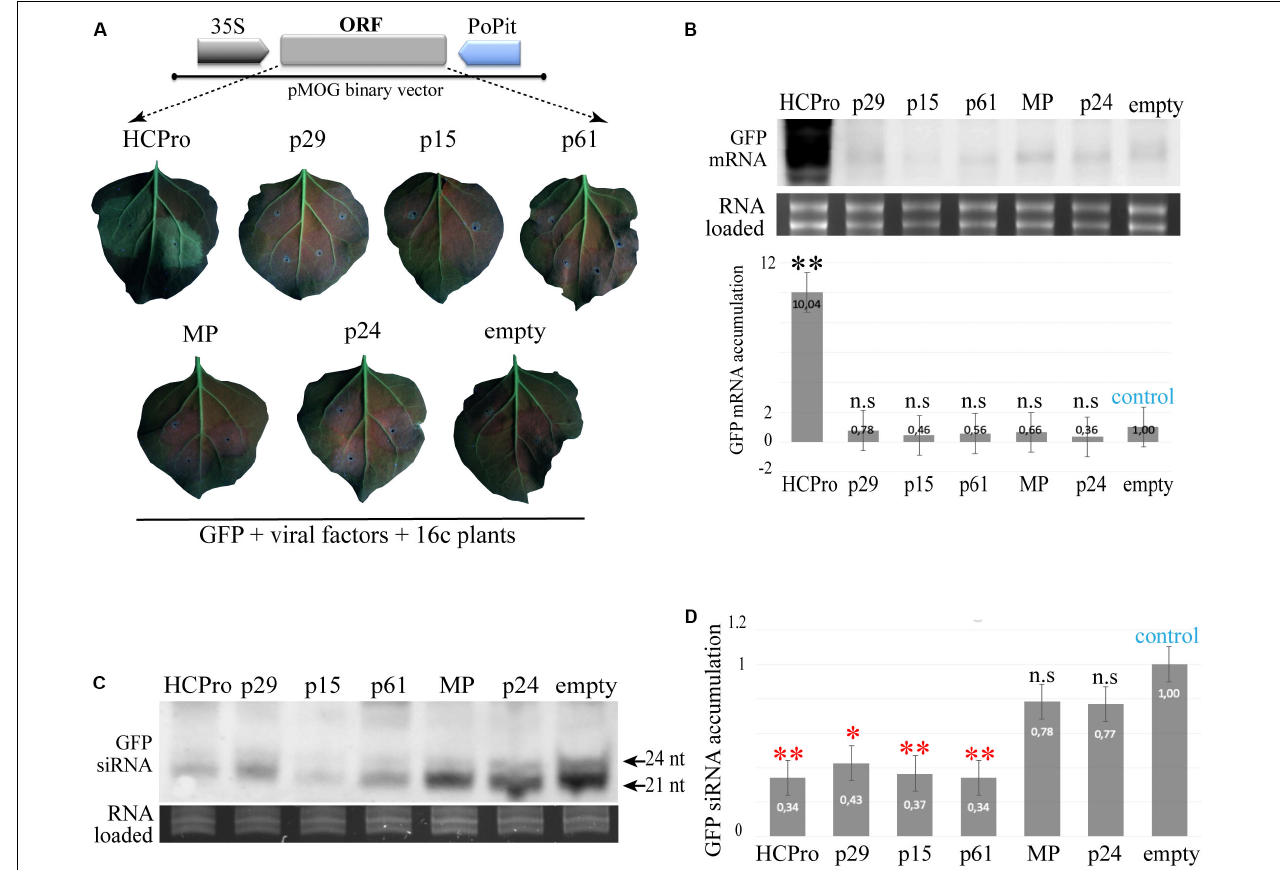
FIGURE 1 | Transient expression of CiLV-C encoded proteins in Nicotiana benthamiana 16c and northern blot analysis of the accumulation of GFP derived small RNAs (siRNAs). (A) Fluorescent images of N. benthamiana 16c leaves co-infiltrated with agrobacterium suspension carrying pMOG 800 binary vector containing individual CiLV-C ORFs and eGFP used to trigger the silencing of the GFP transgene. The schematic representation corresponds to the expression cassette used for transient expression of the CiLV-C proteins indicated, HCPro and GFP. The ORFs were cloned between CaMV 35S promoter and potato proteinase inhibitor terminator (PoPit). pMOG-HCPro and pMOG empty co-infiltrated with pMOG-GFP were used as positive and negative controls, respectively. The GFP fluorescence was not observed in leaves infiltrated with each of the CiLV-C proteins at 6 days post-infiltration. Three independent experiments were performed, each one included the infiltration of 10 plants per construct. (B) Northern blot analysis of GFP mRNA extracted at 4 dpi from the leaves infiltrated with the combination constructs above referred were performed using a dig-riboprobe complementary to the GFP gene. rRNA stained with ethidium bromide indicates equal loading of samples. The graph represents the relative accumulation of mGFP RNAs corresponding to the average of three northern blot from three independent experiments. The value of the averages obtained from the band quantification was normalized in relation to the respective negative control (pMOG-empty). The bands were quantified using the ImageJ version 2.0cr software with ISAC plugin and error bars represent standard deviation. Statistical analysis were done using Student’s t -test. Black asterisks ( ∗ ) indicate significantly increased viral gene accumulation compared to the control. ∗∗ , p < 0.01; n.s, no significant difference. P -values were obtained from pairwise comparations between control vs. viral factor. (C) Northern blot of GFP-specific siRNA extracted from N. benthamiana wt and 16c patches at 4 dpi co-infiltrated with constructs expressing the GFP plus constructs expressing the HCPro (positive control) and p29, p15, p61, MP, and p24 CiLV-C proteins, using a mix of three 50 nt riboprobes complementary to the GFP gene (Martinez-Perez et al., 2019). Negative control (empty) corresponds to patches co-infiltrated with agrobacterium cultures carrying the GFP construct and the empty binary plasmid. Small RNAs of 21 and 24 nt are indicated. rRNA stained with ethidium bromide indicates equal loading of samples. (D) The graph represents the relative accumulation of GFP siRNA, referred to the construct carrying the GFP (empty) from three independent experiments. The value of the averages obtained from the band quantification was normalized in relation to the respective negative control (empty). Error bars represent standard deviation. Statistical analyses were done using Student’s t -test. Red asterisks ( ∗ ) indicate significantly decreased viral gene accumulation compared to the control. ∗∗ , p < 0.01; ∗ , p < 0.05; n.s, no significant